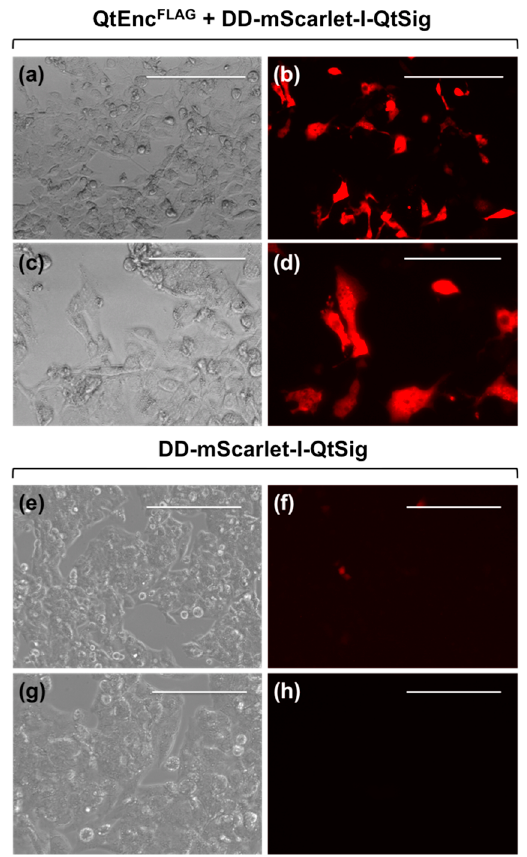
Figure 1. Fluorescent microscopy images of HepG2 cells expressing QtEnc FLAG nanoshell and DD- mScarlet-I-QtSig (QtEnc FLAG + DD-mScarlet-I-QtSig) cargo protein ( a – d ) and DD-mScarlet-I-QtSig cargo protein alone ( e – h ). ( a , c , e , g ): Differential interference contrast microscopy images; ( b , d , f , h ): RFP-channel fluorescence images. The scale bars in ( a , b , e , f ) correspond to 200 µm; the scale bars in ( c , d , g , h ) correspond to 100 µm.